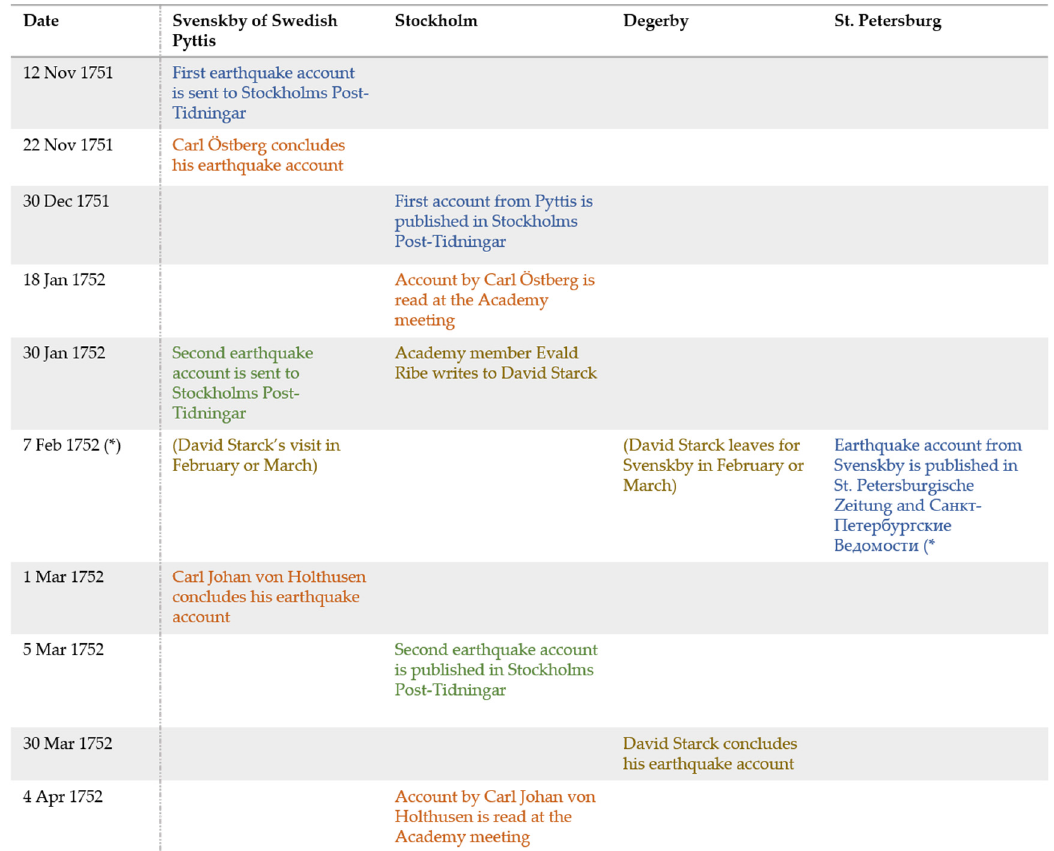
Figure 3. Timeline of the reporting investigated. The dates are according to Julian calendar except for (*) which follows the Russian calendar.